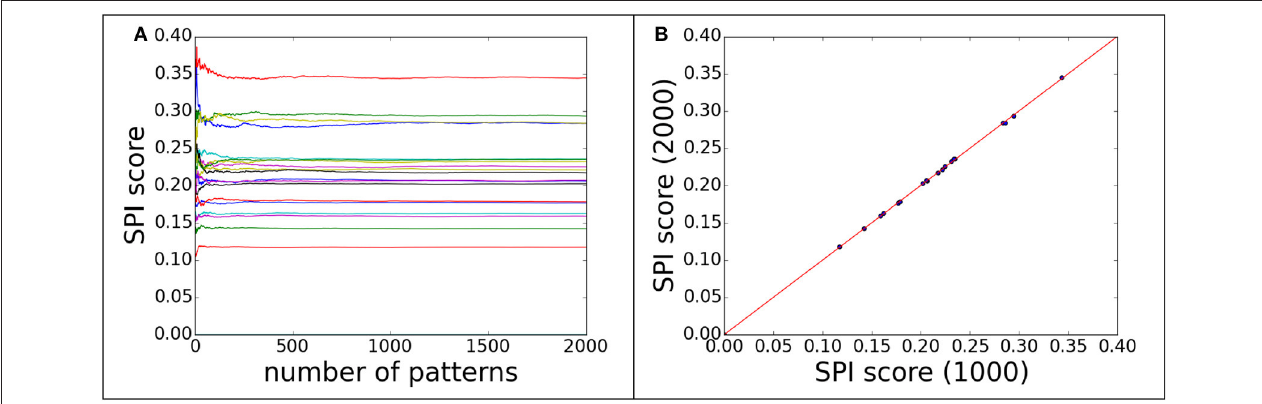
FIGURE 2 | The convergence of SPI-score for patterns with correct orientations. 60 decoys from complex#1 are used to demonstrate the convergence progress of SPI-score. (A) the SPI-score is plotted as a function of pattern quantity, each line represent the SPI-score of one predicted decoy model by comparing model patterns to “experimental” data. (B) The comparison of SPI-scores computed using 1,000 or 2,000 scattering patterns, whose orientations are random.